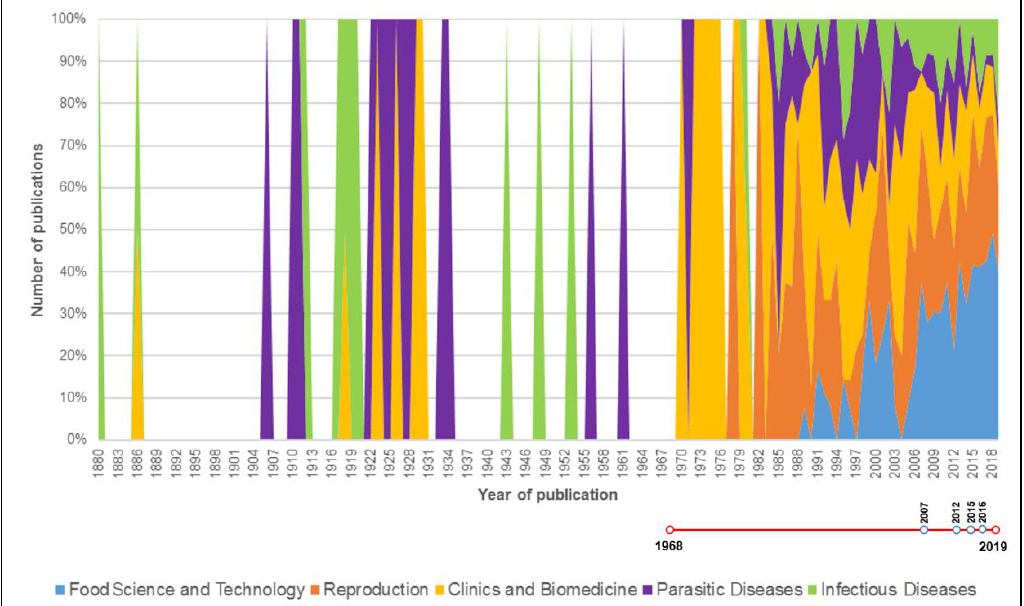
Figure 7. Numerical evolution of the five most popular items in international camel research from 1880 to 2019. Topics with publication numbers below 90 were omitted to improve the interpretability of the results. Timeline is represented below the graph in red, with blue-contoured spots marking the moment of release of a regulation document.